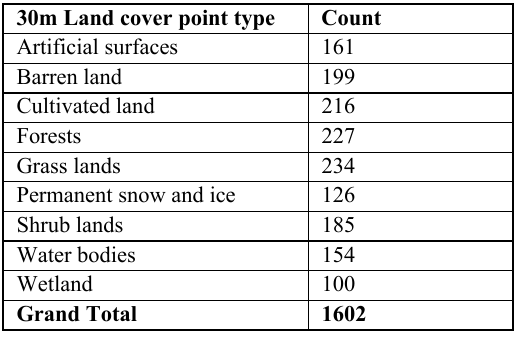
Table 1. Number of sample location for each Land cover type